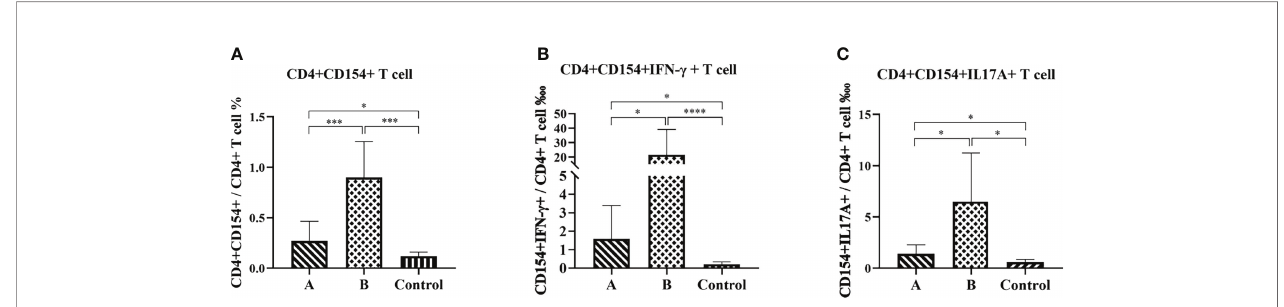
FIGURE 7 | Antigen-speci fi c CD4+ T cell immune response. Eight weeks after the H. pylori challenge, the spleens were collected to prepare a single cell suspension. After staining with intracellular cytokines, fl ow cytometry was used to determine the proportion of CD4+CD154+ T cells (A) , CD4+CD154+IFN- g + T cells (B) , and CD4+CD154+IL17A+ T cells (C) in total CD4+ T cells. The data were presented as mean ± SD. Brown-Forsythe and Welch ANOVA followed by Tamhane2 were used to analyze the data in panels (A – C) The nonparametric Mann-Whitney test was used to analyze the data in (B) * p < 0.05, *** p < 0.001, **** p <